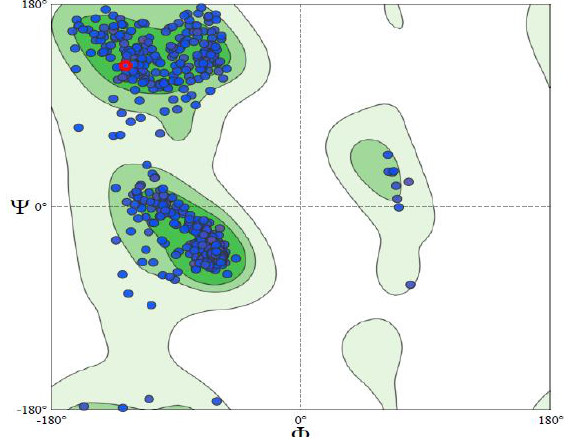
and Ramachandran favoured was 97.75%.